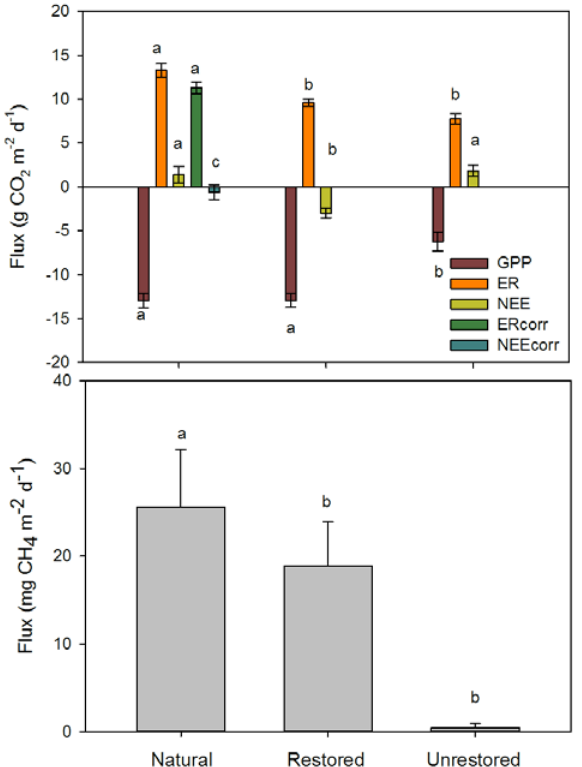
Figure 2. Comparison of fluxes of carbon dioxide (CO 2 ; g CO 2 m -2 d -1 ) (GPP = gross primary production, NEE = net ecosystem exchange, ER = ecosystem respiration) and methane (CH 4 ; mg CH 4 m -2 d -1 ) at peatlands restored using the moss layer transfer technique in eastern and western Canada (top) and peatlands formerly used for horticultural peat extraction and well-pads (bottom). Error bars give standard error. Negative values indicate uptake by the